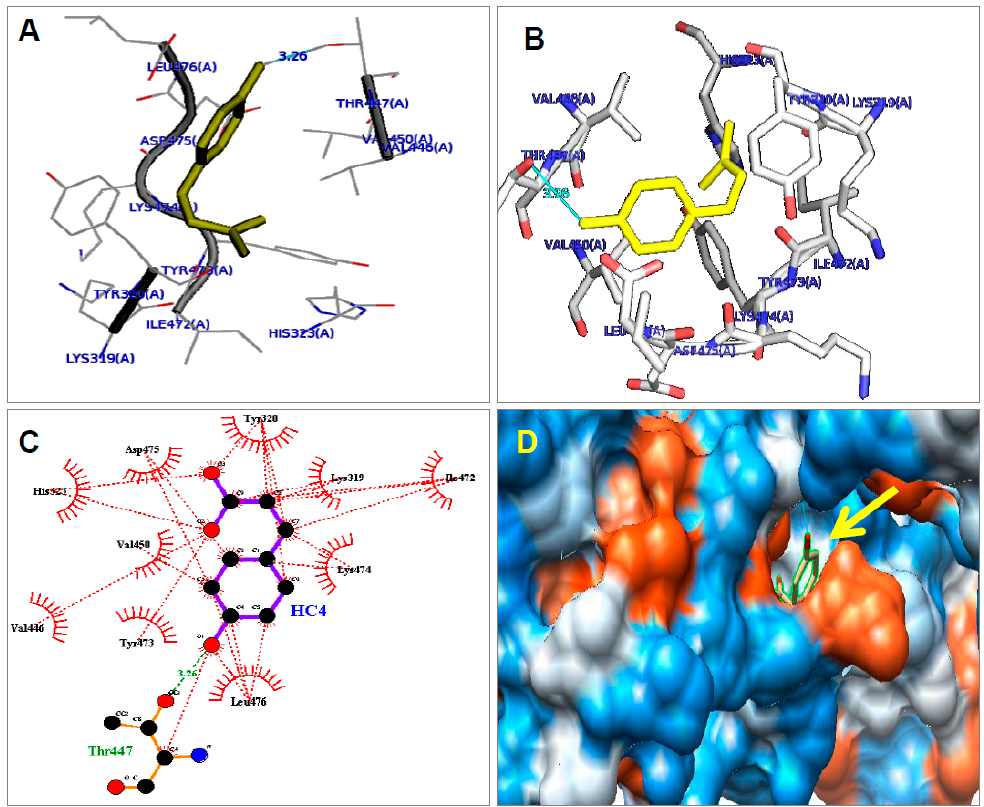
Figure 7. Interaction of coumaric acid (FA) with amino acids in PPAR- γ 2 receptor. ( A , B ) coumaric acid with PPAR- γ 2 in stick model; ( C ) schematic diagram of PPAR- γ 2 with coumaric acid; and ( D ) electrostatic surface of PPAR- γ 2 alongside of the LXXLL (L-leucine, X- any amino acids) motif with CA.